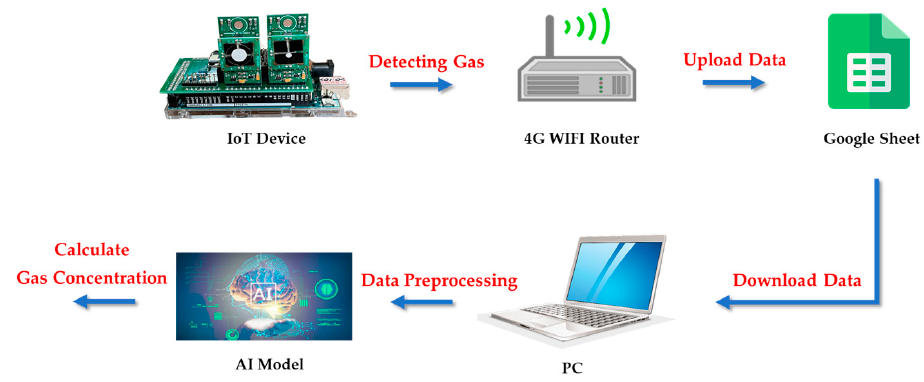
Figure 2. Schematic diagram of the architecture of the Internet of Things.